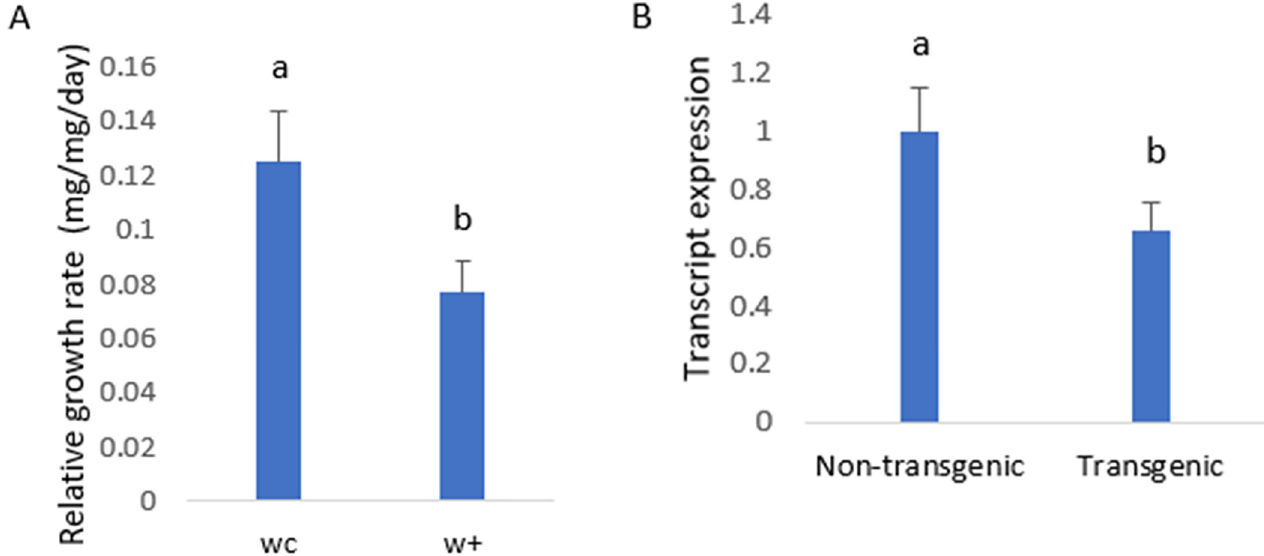
Fig 10. (A) Relative growth rate comparison estimates between larvae that were fed with non-transgenic Maize (wc) and transgenic maize leaves(w+) (B) dsCHI transcript abundance in C . partellus larvae after dsCHI -transgenic and non-transgenic post feeding. values are mean ± standard error and different letters indicate significant different (p <